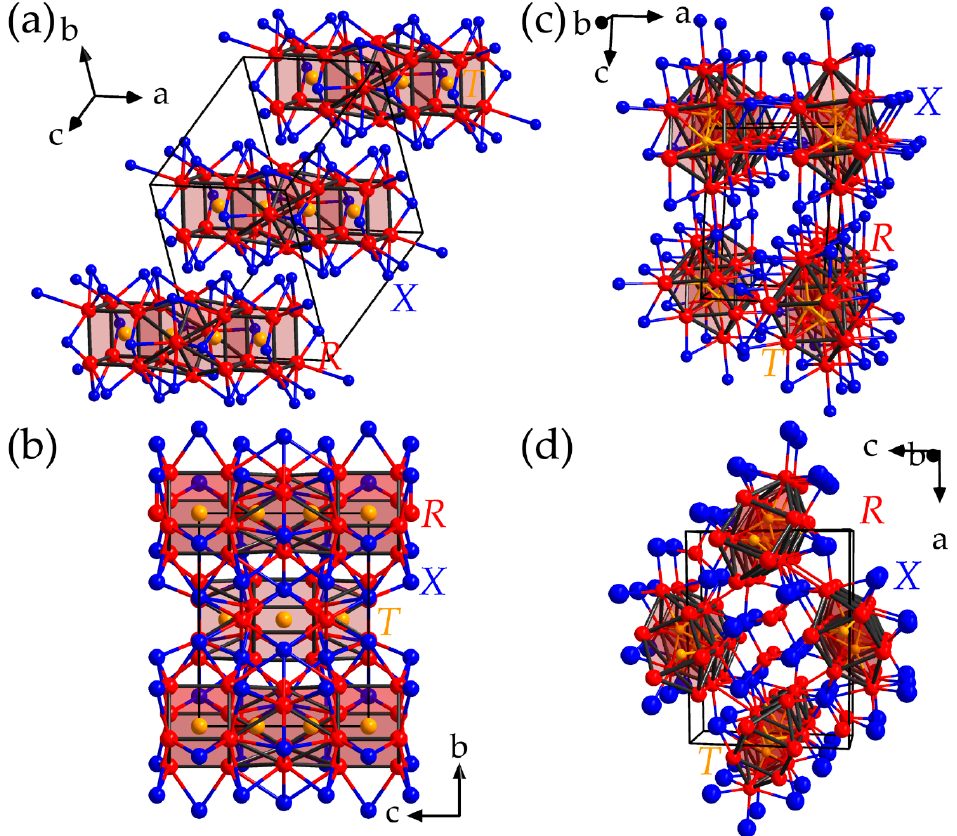
Figure 2. Representations of the crystal structures of: ( a ) [Ir 3 Sc 12 ]Br 16 ; ( b ) [Os 3 Sc 14 ]Te 8 ; ( c ) [MnGd 3 ]I 3 ; and ( d ) [NiGd 4 ]Te 2 . The chains of the transition-metal (yellow) centered rare-earth-metal (red) clusters observed for the halides presented in ( a , c ) have also been identified for the tellurides whose crystal structures are shown in ( b , d ), respectively.